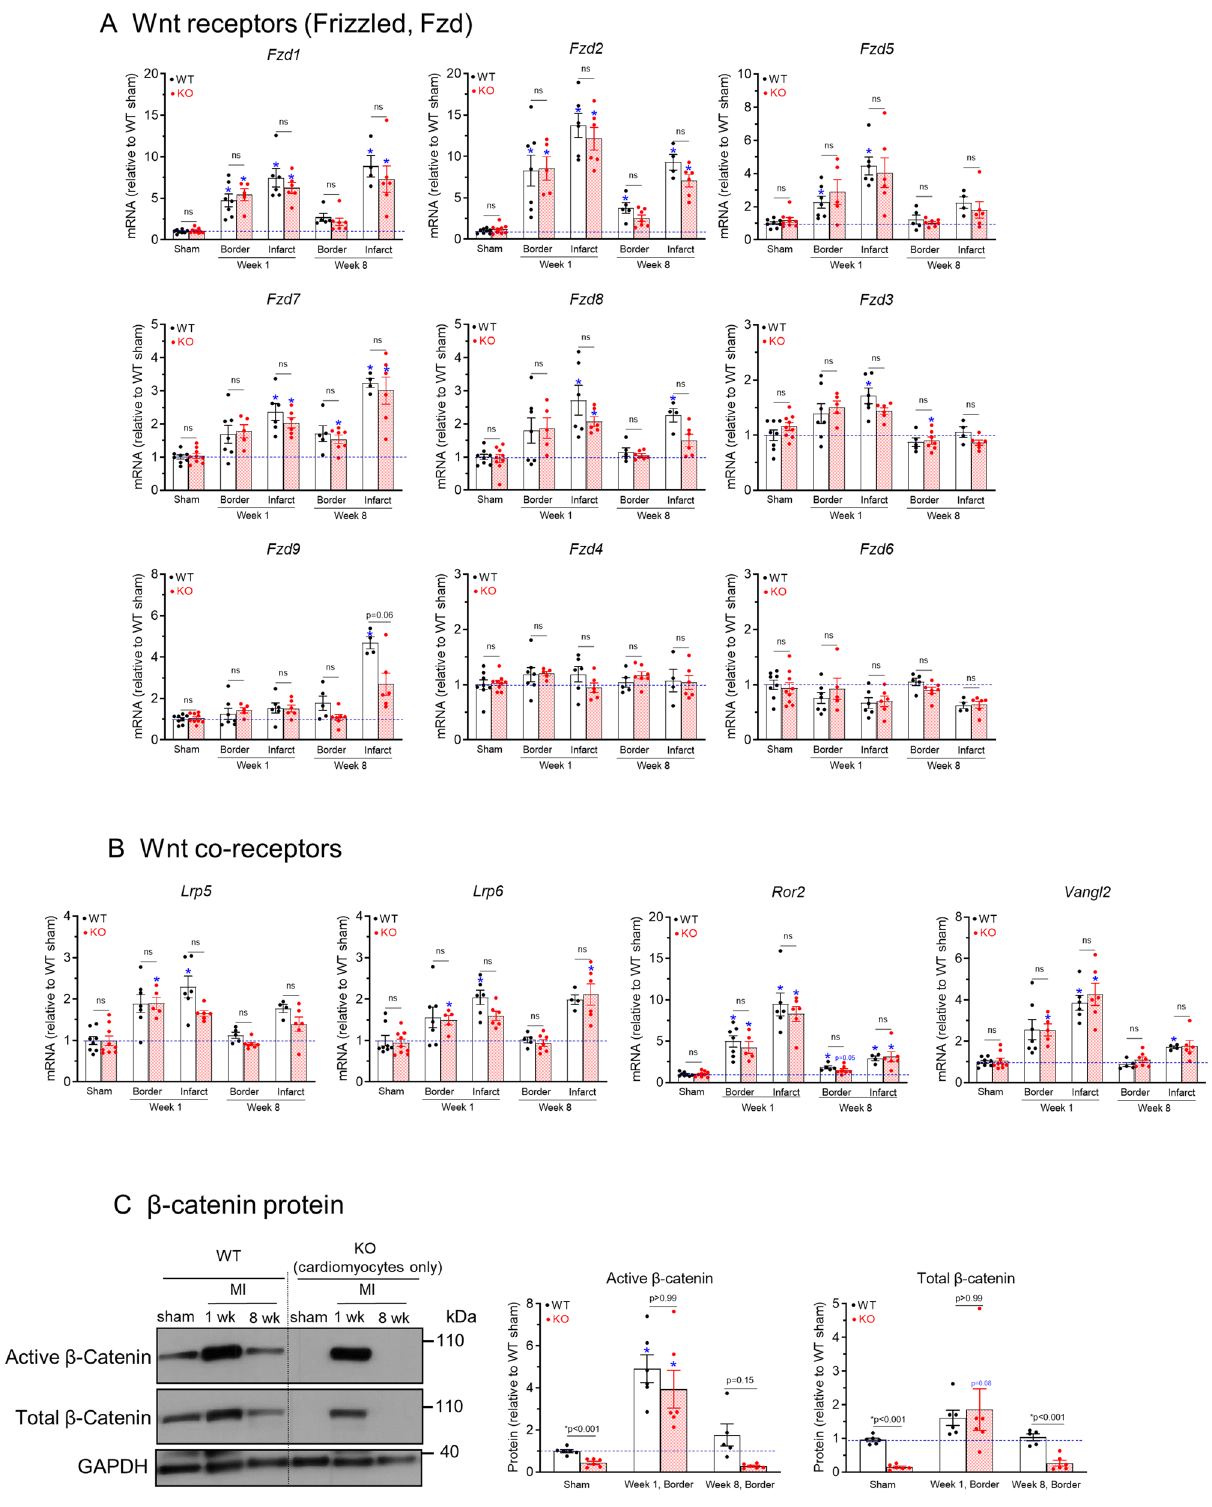
Figure 6. Upregulation of Wnt receptors and co-receptors in myocardial tissues after myocardial infarction. ( A) and ( B) qRT-PCR analyses of transcript levels of Wnt receptors ( A ) and Wnt co-receptors ( B ) in sham, 1-week post MI, and 8-week post MI infarct and border zone myocardium. n = 4–10 per group. ( C) Western blot of border zone tissue (MI, n = 5–6) or left ventricular anterior free wall (sham, n = 5–6) with anti-non- phospho (active) β-catenin (Ser33/Ser37/Thr41) antibody and anti-total β-catenin antibody. GAPDH was used as a loading control. The original uncropped gel images are included in Supplementary Fig. 1. * p < 0.05 vs. corresponding sham groups. “ns” means no significant difference between WT and KO groups. Data were analyzed by two-way ANOVA and Bonferroni post-hoc